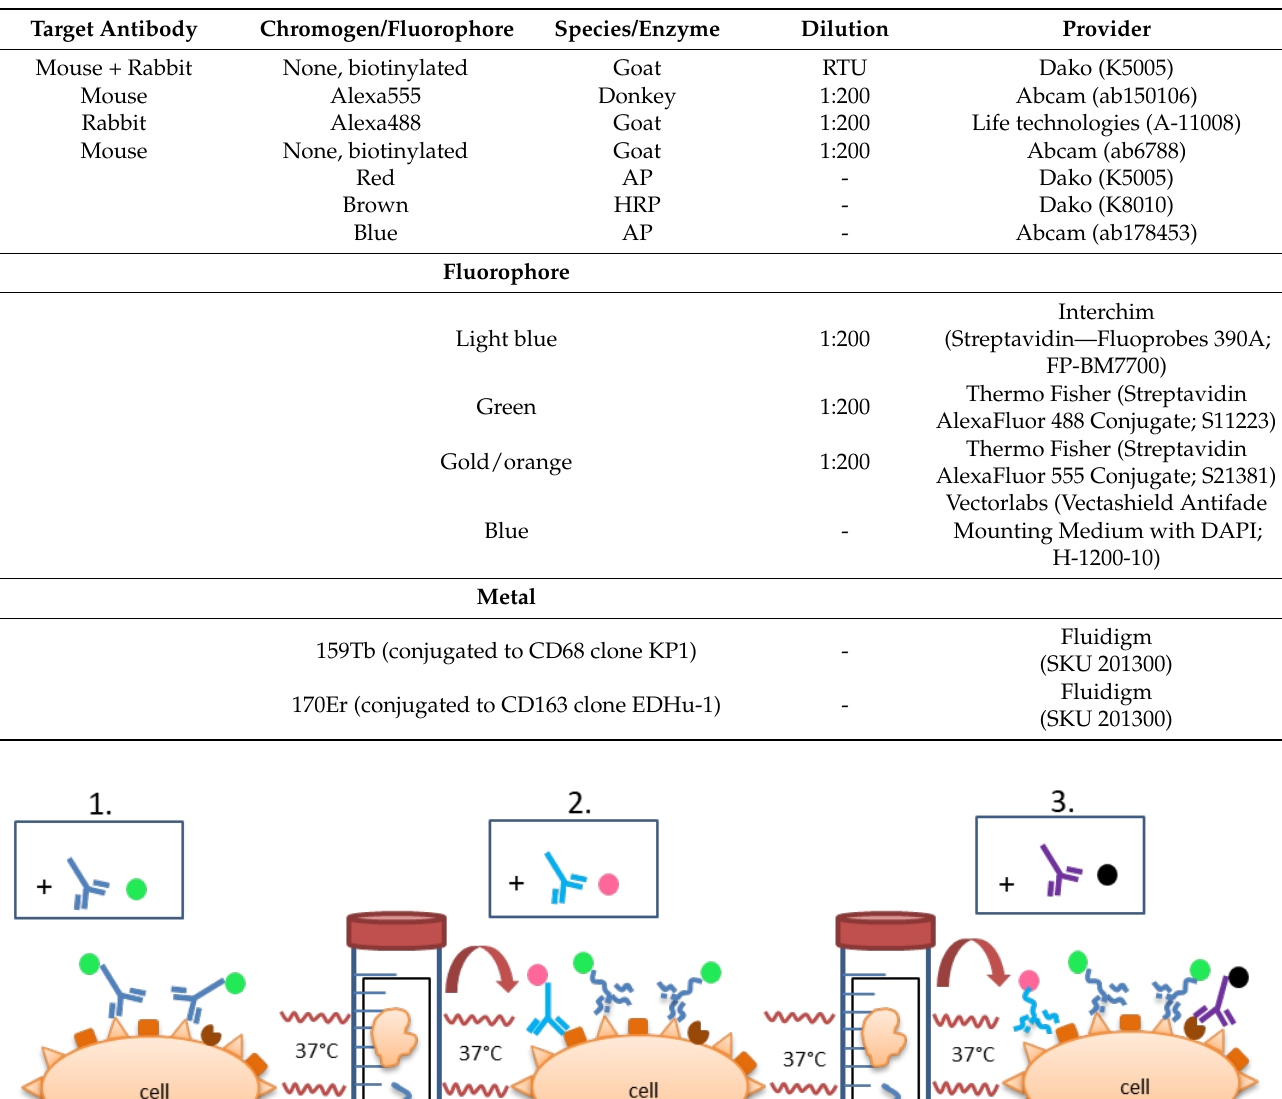
Table 2. Secondary antibodies, chromogens, fluorophores and metals. Except DAPI, the fluorophores not directly coupled to antibodies are linked to streptavidin for binding of biotinylated antibodies.